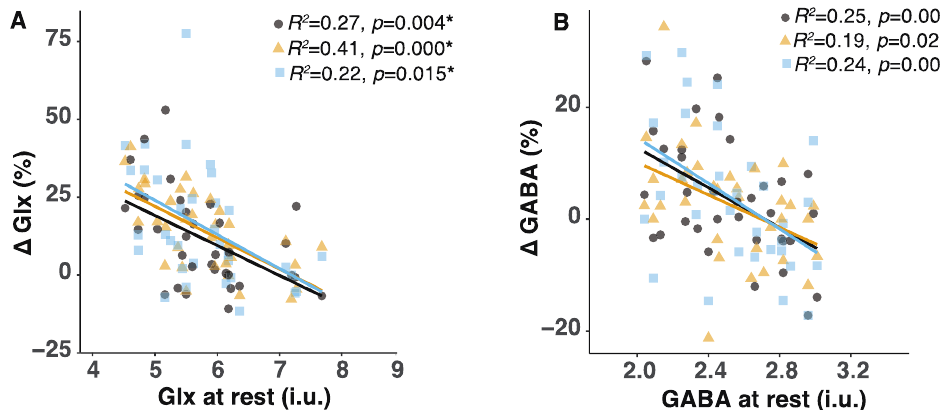
Figure 3. The degree of Glx and GABA increases during the tasks was predicted by the basal level of Glx and GABA content at rest. ( A ) Greater increases in Glx content during the tasks were predicted by a smaller Glx content at rest. ( B ) Greater increases in GABA content during the tasks were predicted by a smaller GABA content at rest. Gray circle symbols represent Glx or GABA increases in block2. Yellow triangle symbols represent Glx or GABA increases in block3. Blue square symbols represent Glx or GABA increases in block4. Asterisks represent that the Glx or GABA content at rest significantly predicted Glx or GABA increases during the tasks at the p level of 0.05.